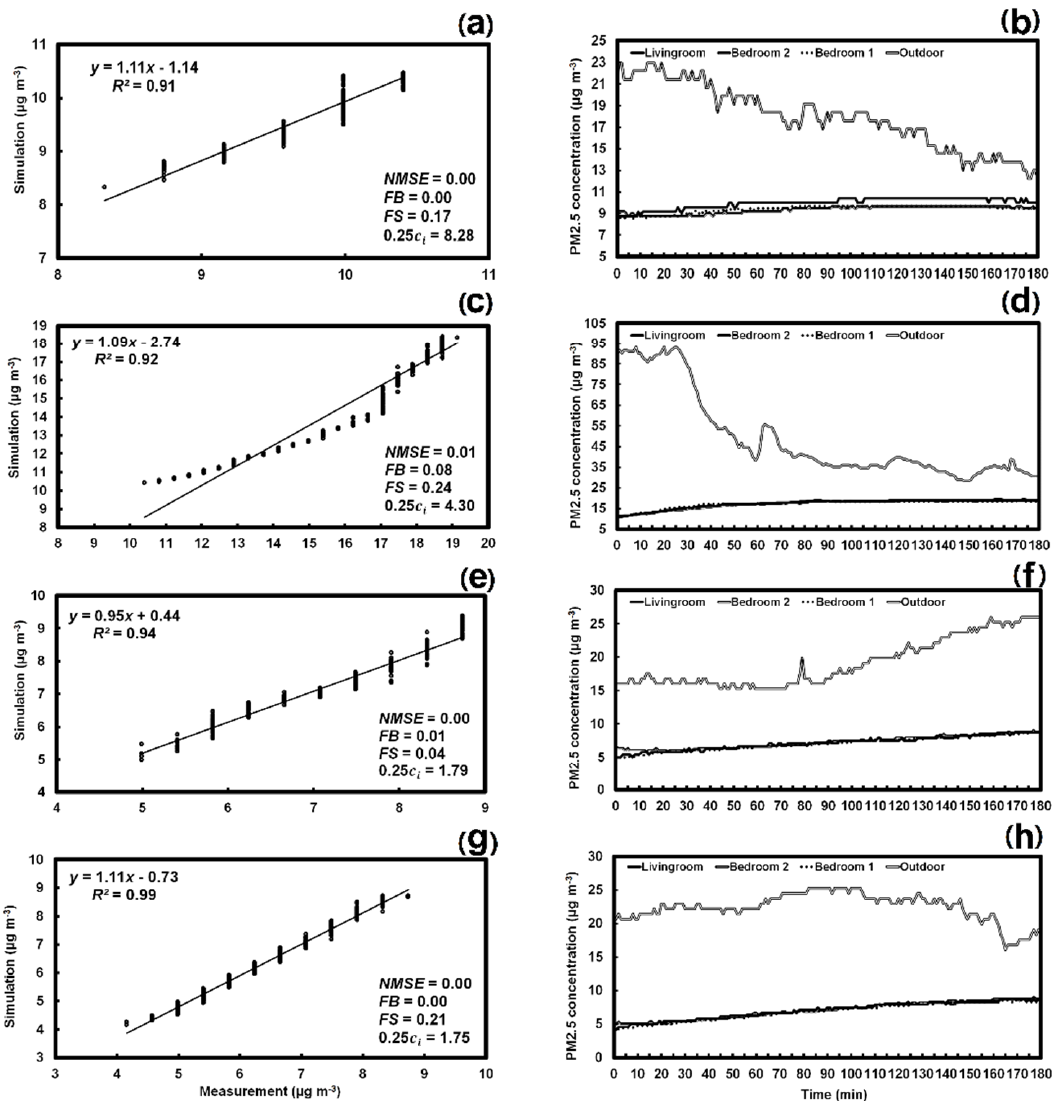
Figure 5. PM 2.5 concentration of CONTAM simulation and measurement in the living room and the measured PM 2.5 concentration in four places (living room, bedroom 1, bedroom 2, and outside) under three-hour natural conditions on four different days: 11 September ( a , b ), 12 September ( c , d ), 13 September ( e , f ), and 15 September ( g , h ), respectively. The y is the simulation, and x is the meas- urement.